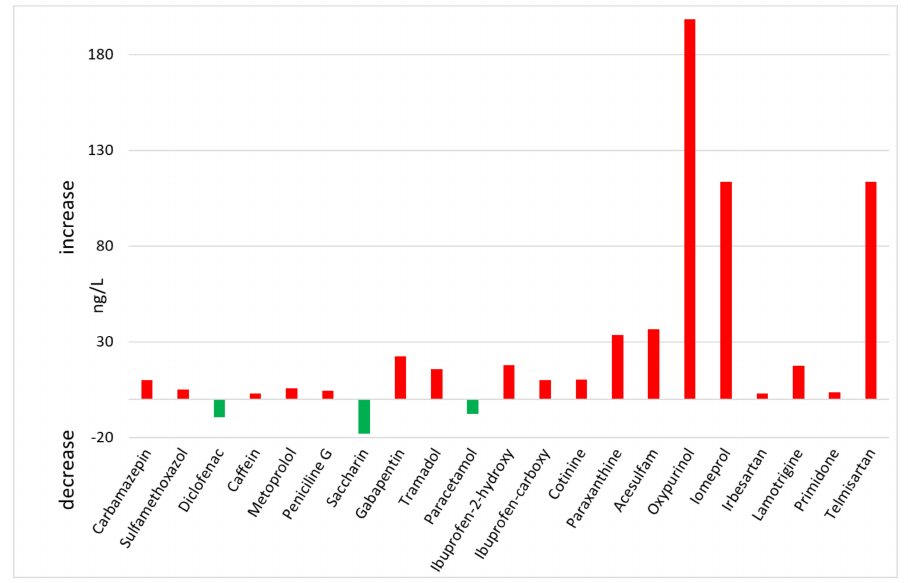
Figure 4. Changes in long-term concentrations of monitored PPCPs on the profiles above and below the wastewater treatment plant at Mlad á Boleslav (in red are substances whose concentrations have increased in this section of the watercourse, the green ones have